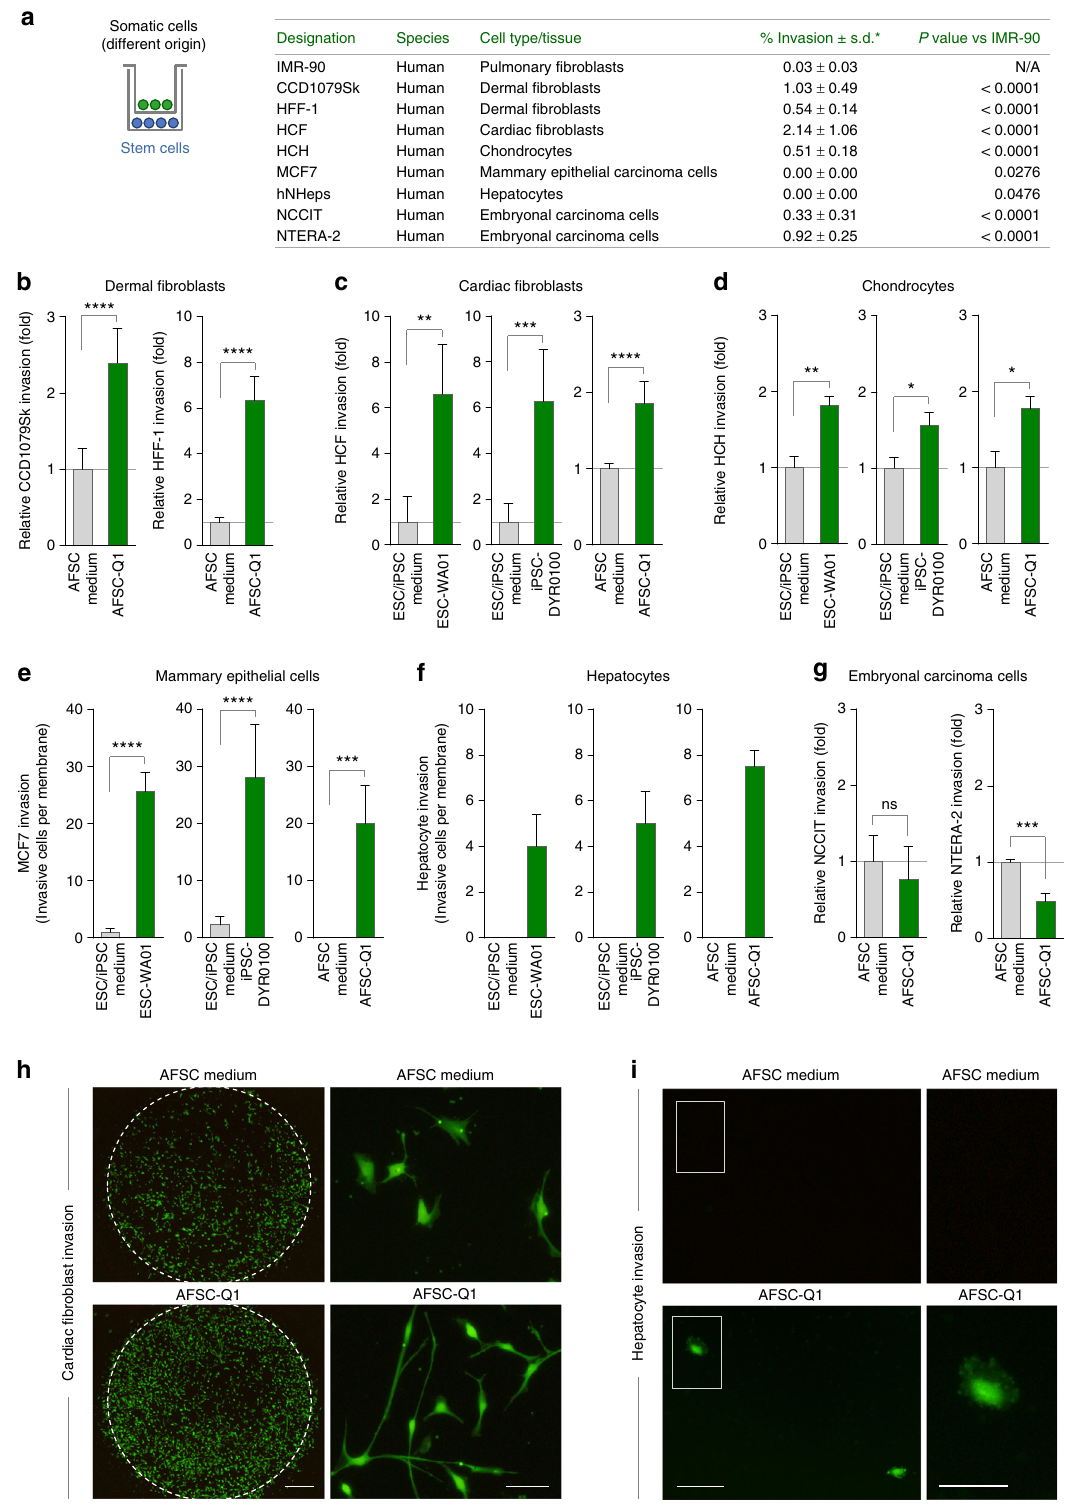
Fig. 2 Human stem cells trigger the invasion of various somatic cell types. a Outline of the invasion experiments in b – i . The table summarises the analysed target cells and their mean invasive capacity. *Invasion data are given as the percentage of invasive cells evaluated via gradient-based transwell invasion assay ( n ≥ 3; mean ± s.d.). N/A, not applicable. b – g Transwell invasion assay of indicated target cells upon co-culture with stem cells. Data are presented as the fold change of the corresponding medium control or the absolute number of invasive cells per membrane ( n ≥ 3; mean ± s.d.). h Calcein-staining of invasive cardiac fi broblasts upon AFSC co-culture representative of data in c . Scale bar , left panels , 800 μ m; right panels , 100 μ m. i Calcein-staining of invasive hepatocytes upon AFSC co-culture representative of data in f . Scale bar , left panels , 100 μ m; right panels , 50 μ m. * P < 0.05; ** P < 0.01; *** P < 0.001; **** P < 0.0001; ns, P > 0.05 (not signi fi cant) by unpaired, two-tailed Student ’ s t -test analysis. n refers to biological